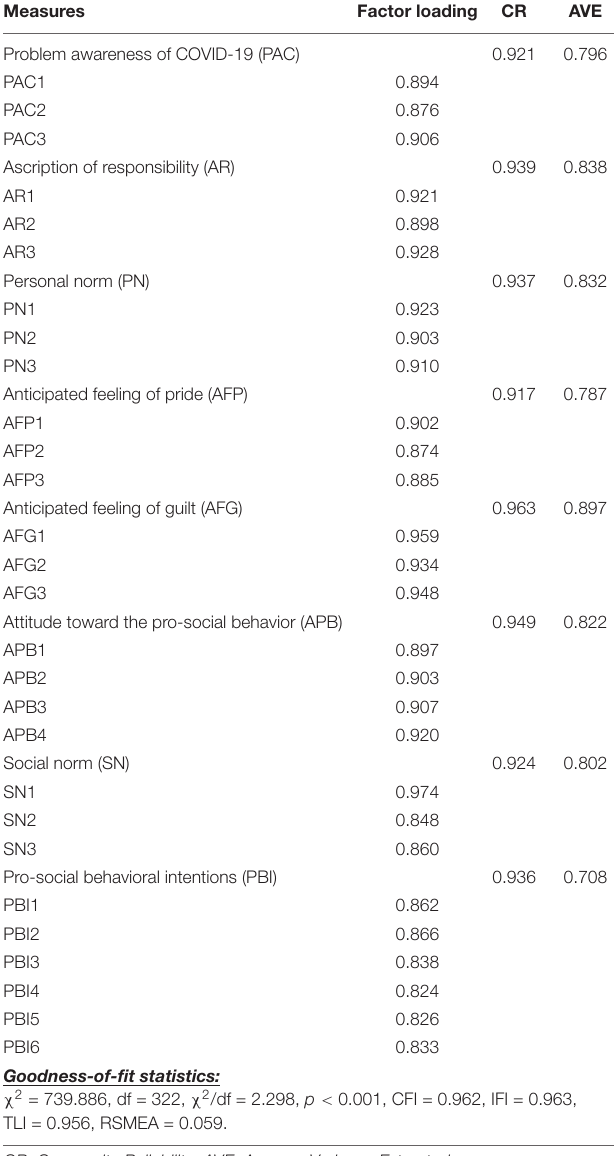
TABLE 2 | Measurement items and results of confirmatory factor